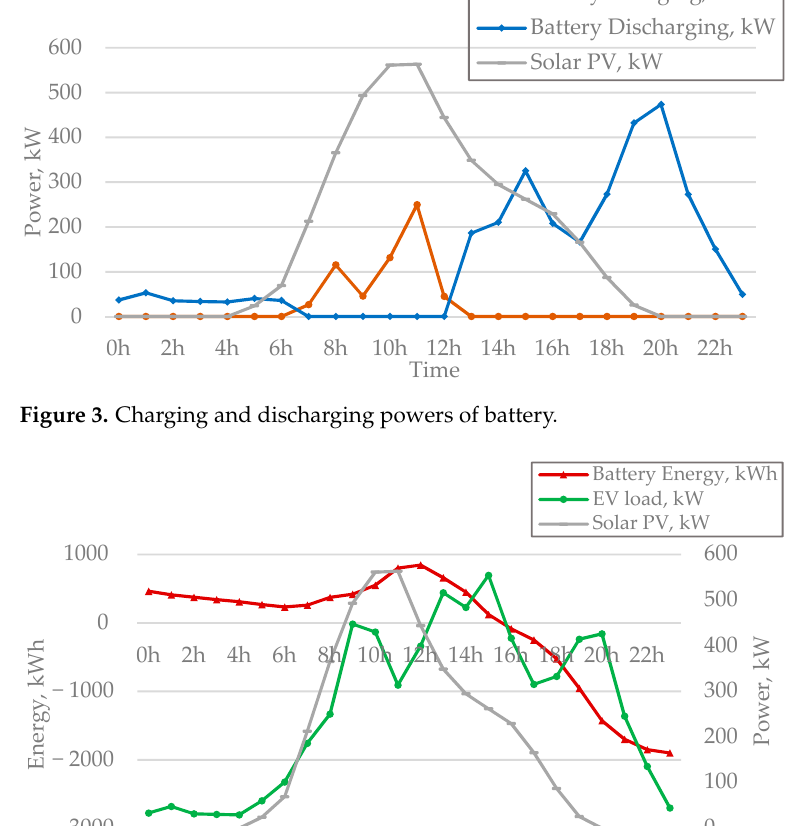
Figure 4. Battery energy, load EV, and the solar power.